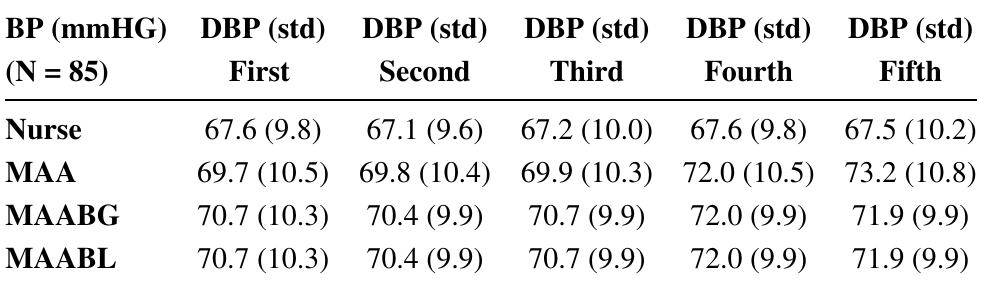
Table 4. Summary of the averaged diastolic blood pressure (DBP) estimates by the nurse, the maximum amplitude algorithm (MAA), MAA using Bayesian with Gaussian (MAABG), and the maximum amplitude algorithm (MAA), MAA using Bayesian with Laplacian (MAABL); std is the standard deviation; first to fifth is the sequence of the